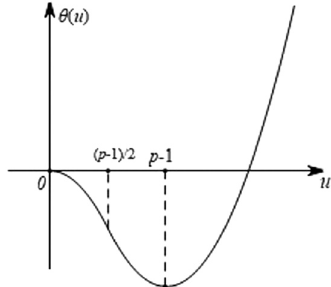
Figure 4: The graph of ( ) θ u